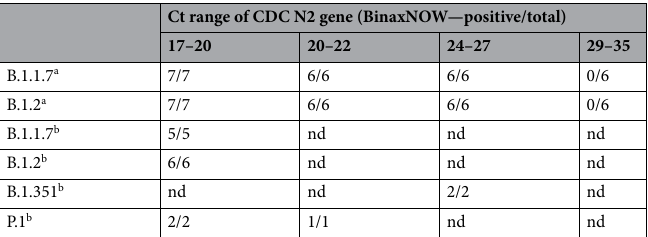
Table 2. Sensitivity of BinaxNOW for four relevant VOC versus Cycle threshold (Ct) values by RT-PCR. ND not determined. a Pooled inactivated clinical samples. b Individual non-inactivated clinical samples. RNA was purified from 140 µl aliquots by using QIAamp Viral RNA kit (Qiagen) or MagMax Viral RNA Isolation Kit (Applied Biosystems) and KingFisher Apex System (ThermoFisher), and were reversed transcribed into cDNA and amplified in a one-step RT-PCR multiplex reaction with qScript XLT one-Step RT-qPCR ToughMix (QuantaBio) using nCoV N2 combined primer/probe set (Integrated DNA Technologies, IDT), and the LightCycler 480 II instrument (Roche).